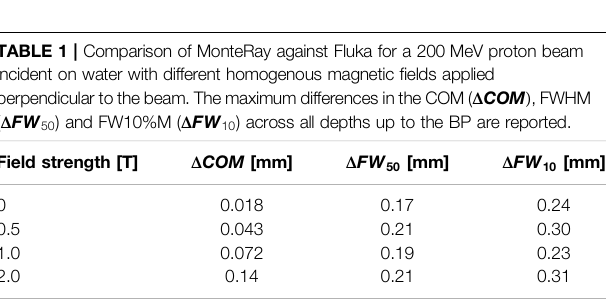
FIGURE 5 | For 200 MeV protons in water, 2D dose distributions calculated with MonteRay (A) and FLUKA (B) are shown in a plane perpendicular to the 2 T magnetic fi eld. In (C) , Lateral pro fi les for 200 MeV protons in water and with magnetic fi eld strengths of 0 T, 0.5 T, 1 T, and 2 T are displayed at the location of the BP. MonteRay ’ s results are indicated by a red line while FLUKA ’ s results are displayed as blue dots.